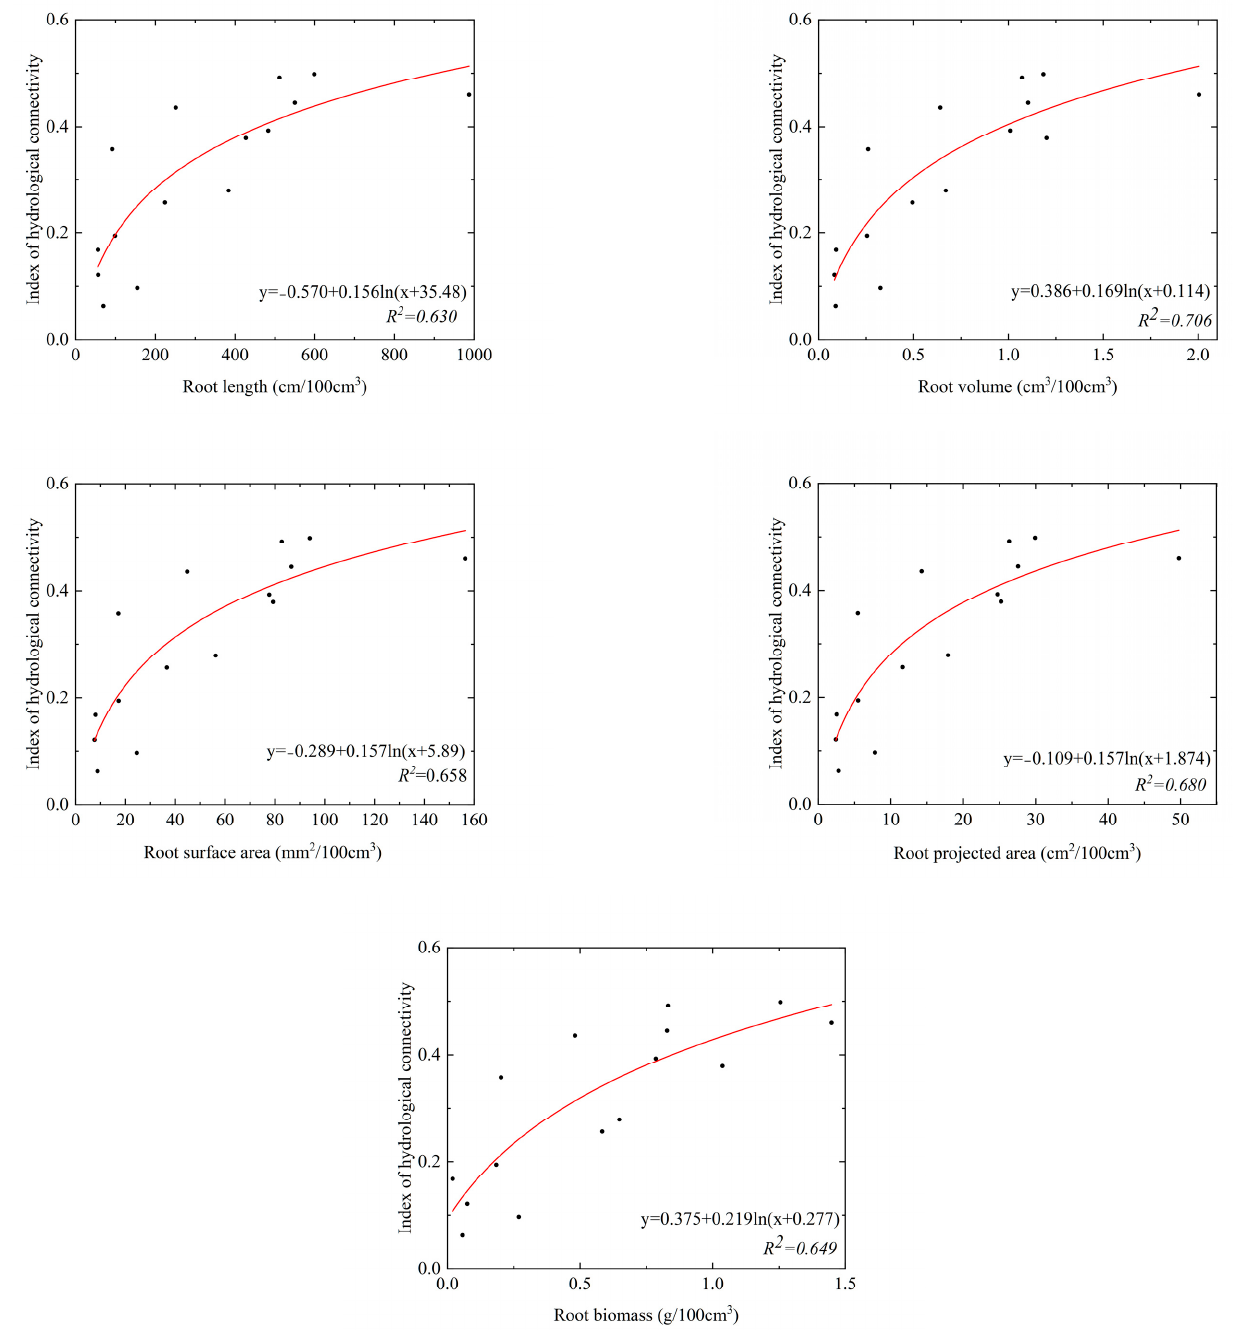
Figure 6. The relationship between the parameters of roots system architecture and IHC in the ZL site.